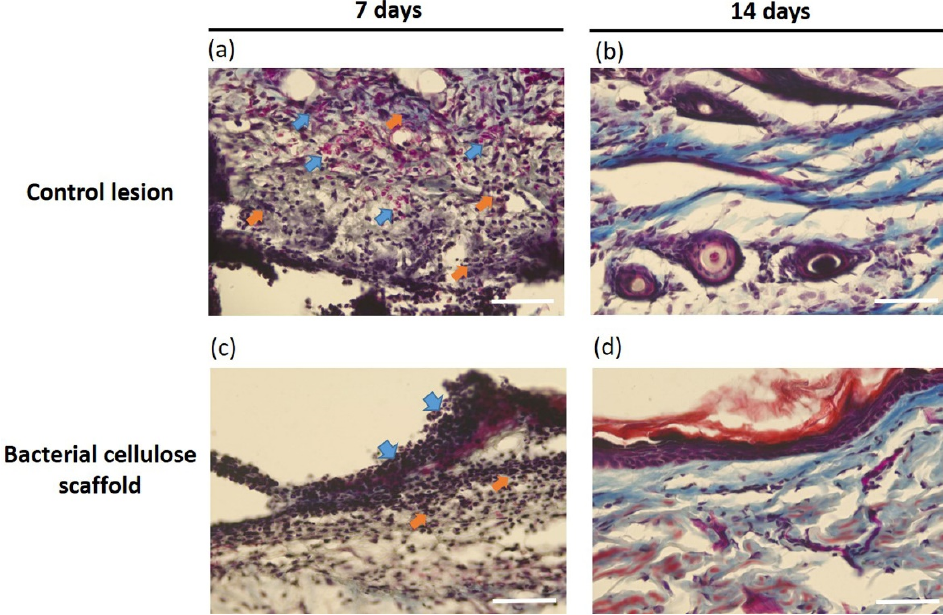
Figure 5. Histological analysis of rat skin defects using Masson’s trichrome staining. ( a , b ) Control lesion group after 7 and 14 days of treatment, respectively. ( c , d ) Bacterial cellulose scaffold group after 7 and 14 days of treatment, respectively (blue arrow = immune cell infiltration; orange arrow = granulation tissue; scale bar = 50 μm).